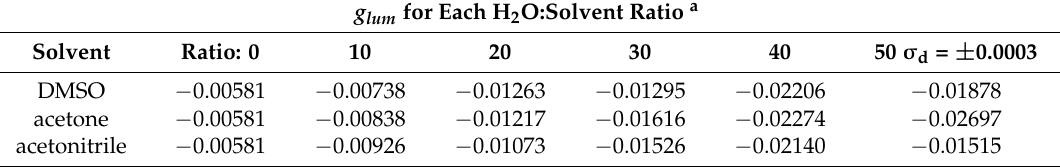
Table 5. Luminescence dissymmetry ratio values ( g lum ) for varying ratios of H 2 O:DMSO, acetone, and